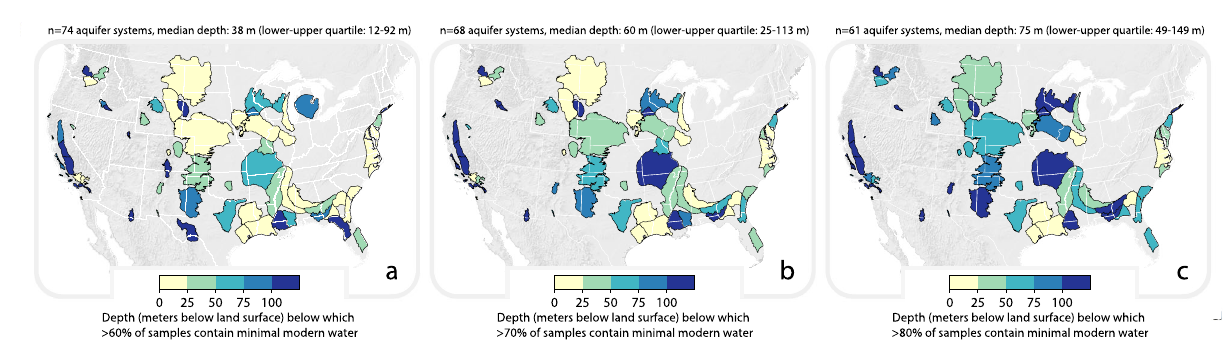
Fig. 2 | Spatial patterns of the depth below which modern groundwater is scarceamong USaquifer systems. Yellow-blue shades representthedepth below which60%( a ),70%( b )or80%( c )ofsamplescontainminimalmoderngroundwater (de fi nedhereaswellwatersamplescontaininglessthan25%moderngroundwater). a The median depth below which >60% of samples contain minimal modern groundwateramong n =74studiedaquifersystems(withsuf fi cientgroundwater 3 H data) is 38m, and the lower – upper quartile range is 12 – 92m. b The median depth